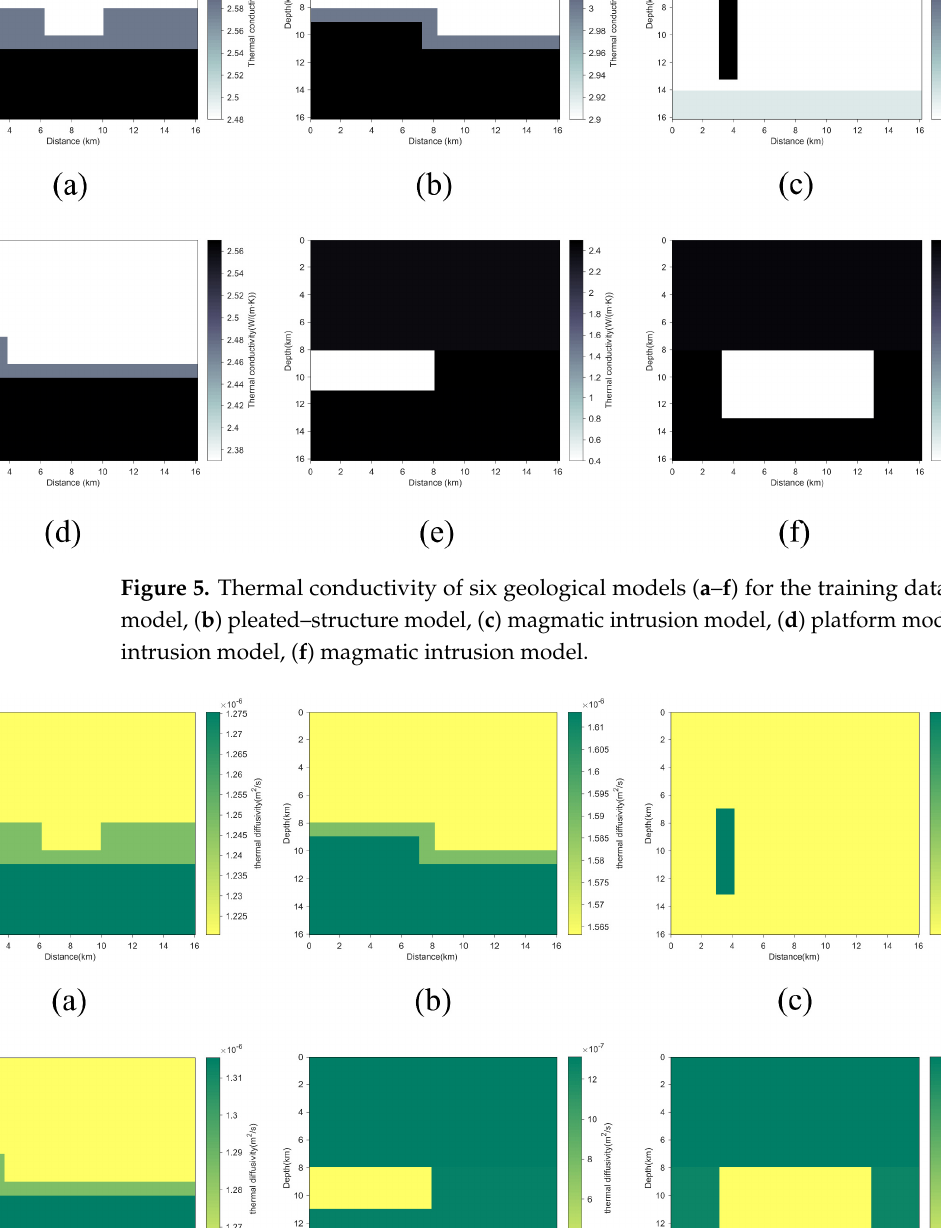
Figure 4. Specific heat capacity of six geological models ( a – f ) for the training data set: ( a ) Graben model, ( b ) pleated − structure model, ( c ) magmatic intrusion model, ( d ) platform model, ( e ) mag- matic intrusion model, ( f ) magmatic intrusion model.